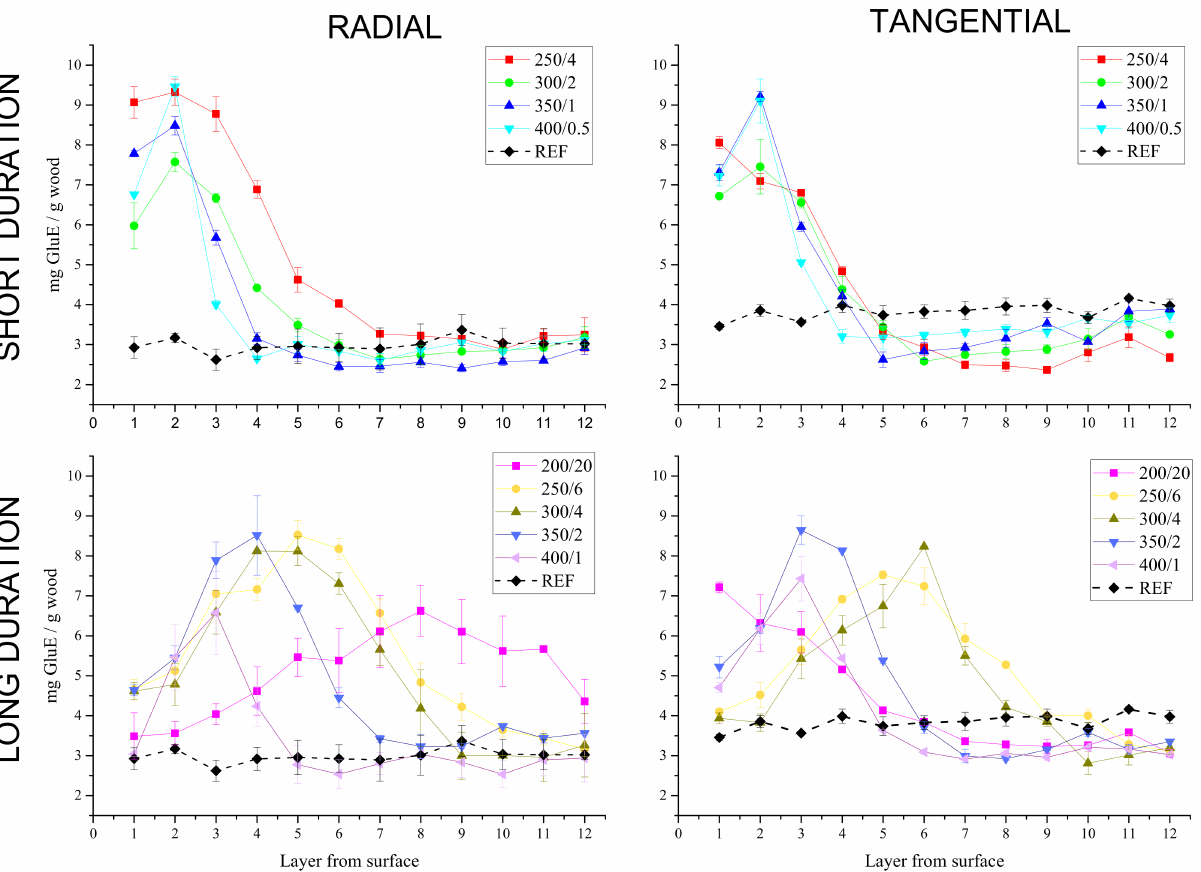
Figure 4. The effect of radial and tangential charring on the total carbohydrate content within 6 mm from wood surface (12 layers; each having 0.5 mm